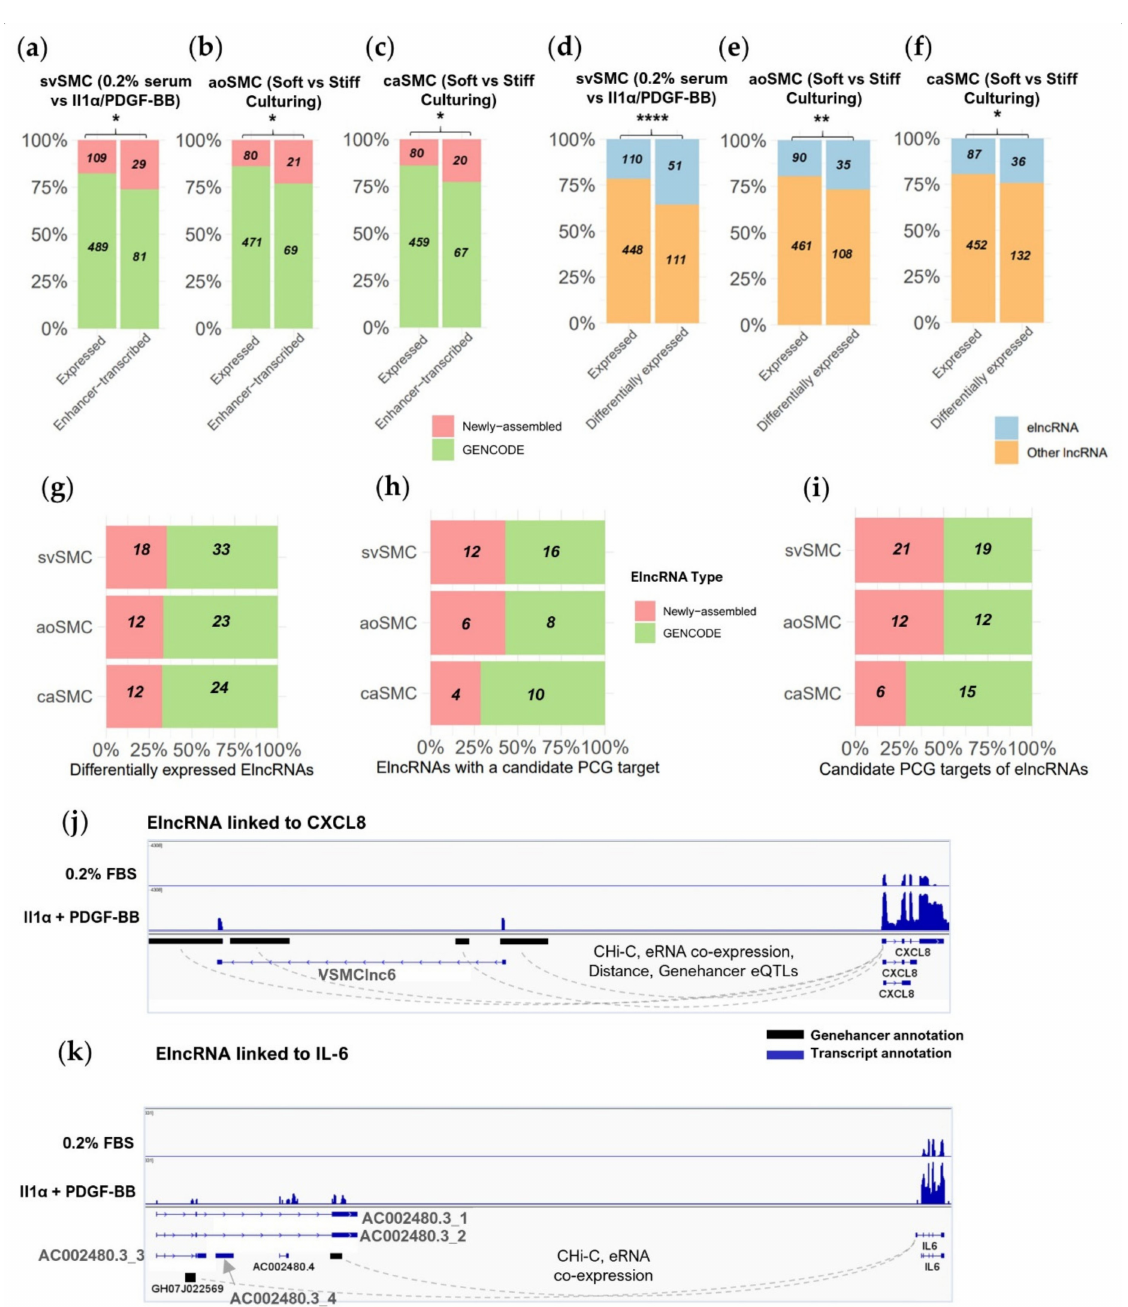
Figure 4. Increased coverage of elncRNAs and their association with VSMC pathology. ( a – c ) Proportion of newly assembled vs. GENCODE lncRNAs for expressed lncRNAs or elncRNAs in the three in vitro VSMC datasets (Fisher’s exact test, background of expressed lncRNAs). ( d – f ) Proportion of elncRNA vs. other lncRNAs amongst expressed or differentially expressed lncRNAs (Fisher’s exact test, background of expressed lncRNAs). ( g ) Proportions of newly assembled vs. GENCODE differentially expressed elncRNAs ( h ) Proportions of newly assembled vs. GENCODE elncRNAs with a candidate PCG target. ( i ) Proportion of candidate PCG targets identified for newly assembled and GENCODE elncRNA (any proximal to both types are considered as GENCODE). ( j , k ) Representative RNAseq coverage at two genomic regions with elncRNAs (AC002480.3 and VSMClnc6) linked to cytokine ( IL-6 ) and chemokine ( CXCL8 ) genes by GeneHancer interaction data. ( a – f ) p < 0.0001 ****, p < 0.01 **, p < 0.05